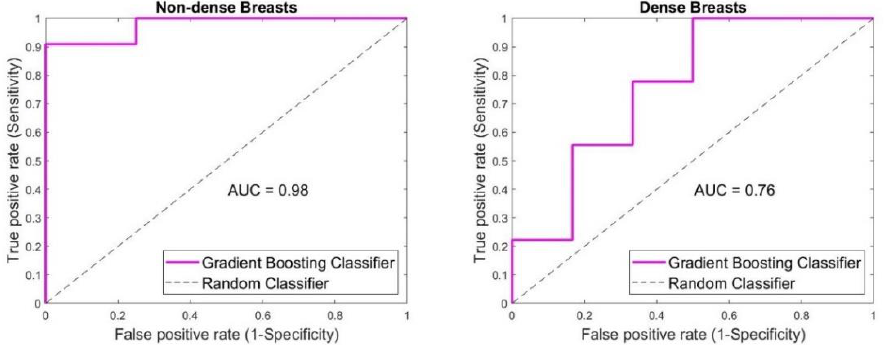
Figure 5. Density effect on SAFE classification outcome. Higher sensitivity, specificity and accuracy (91%, 100% and 93%, respectively) were achieved when non-dense breasts were involved compared to the ones acquired in dense breasts (56%, 83% and 67%, respectively).